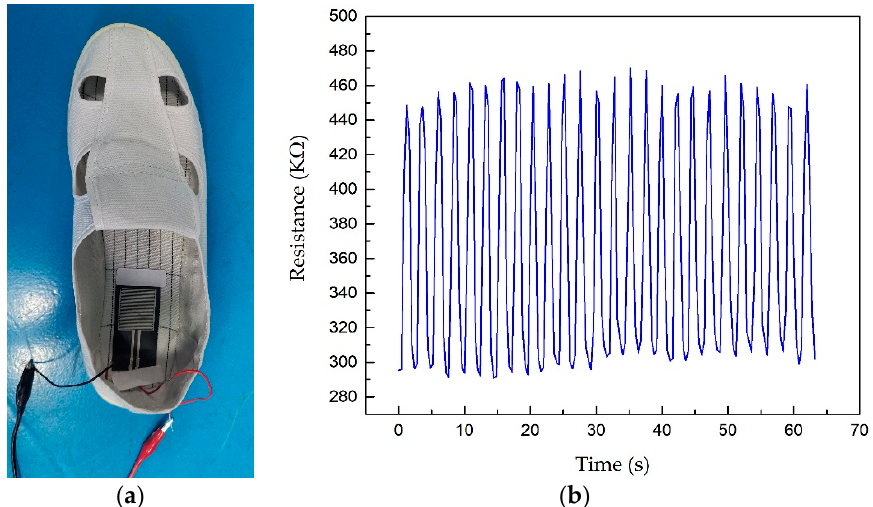
Figure 12. The plantar pressure test of the MoS 2 film sensor. ( a ) The test system of plantar pres- sure; ( b ) output curve of the plantar pressure signal during walking.